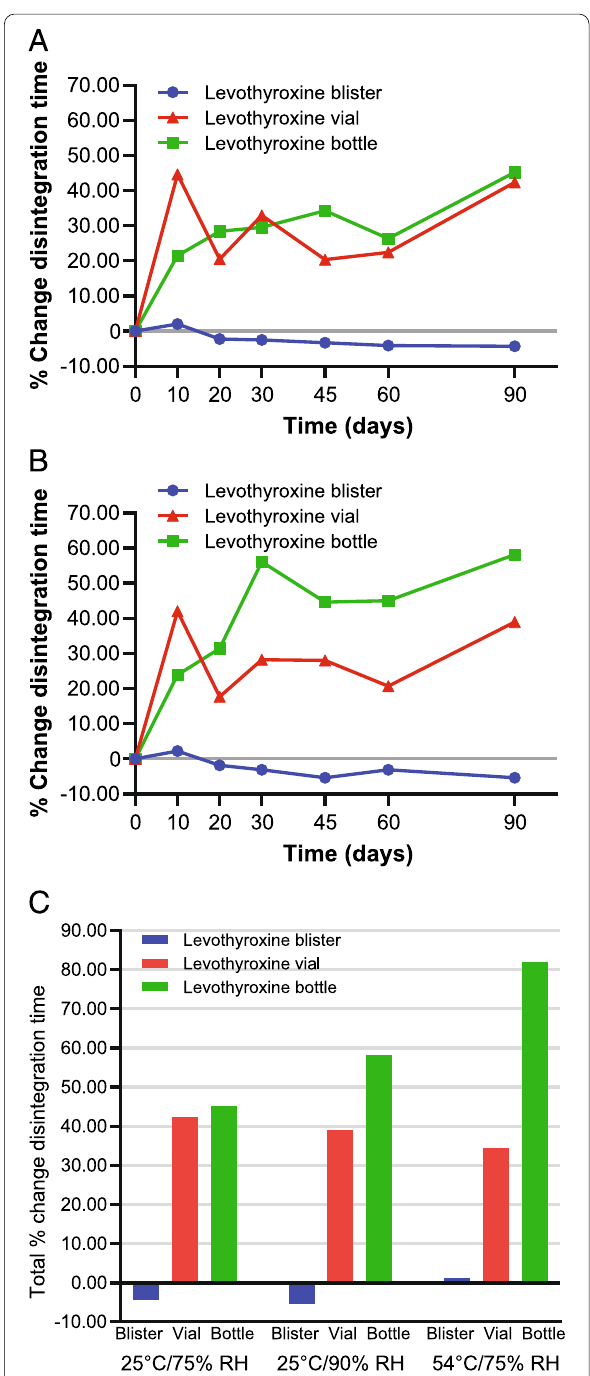
Fig. 3 Change in disintegration time of levothyroxine tablets. A Percent change in disintegration time: 25 °C/75% RH. B Percent change in disintegration time: 25 °C/90% RH. C Total percent change in disintegration time under 90-day patient use or 2-day shipping conditions. Abbreviation: RH, relative